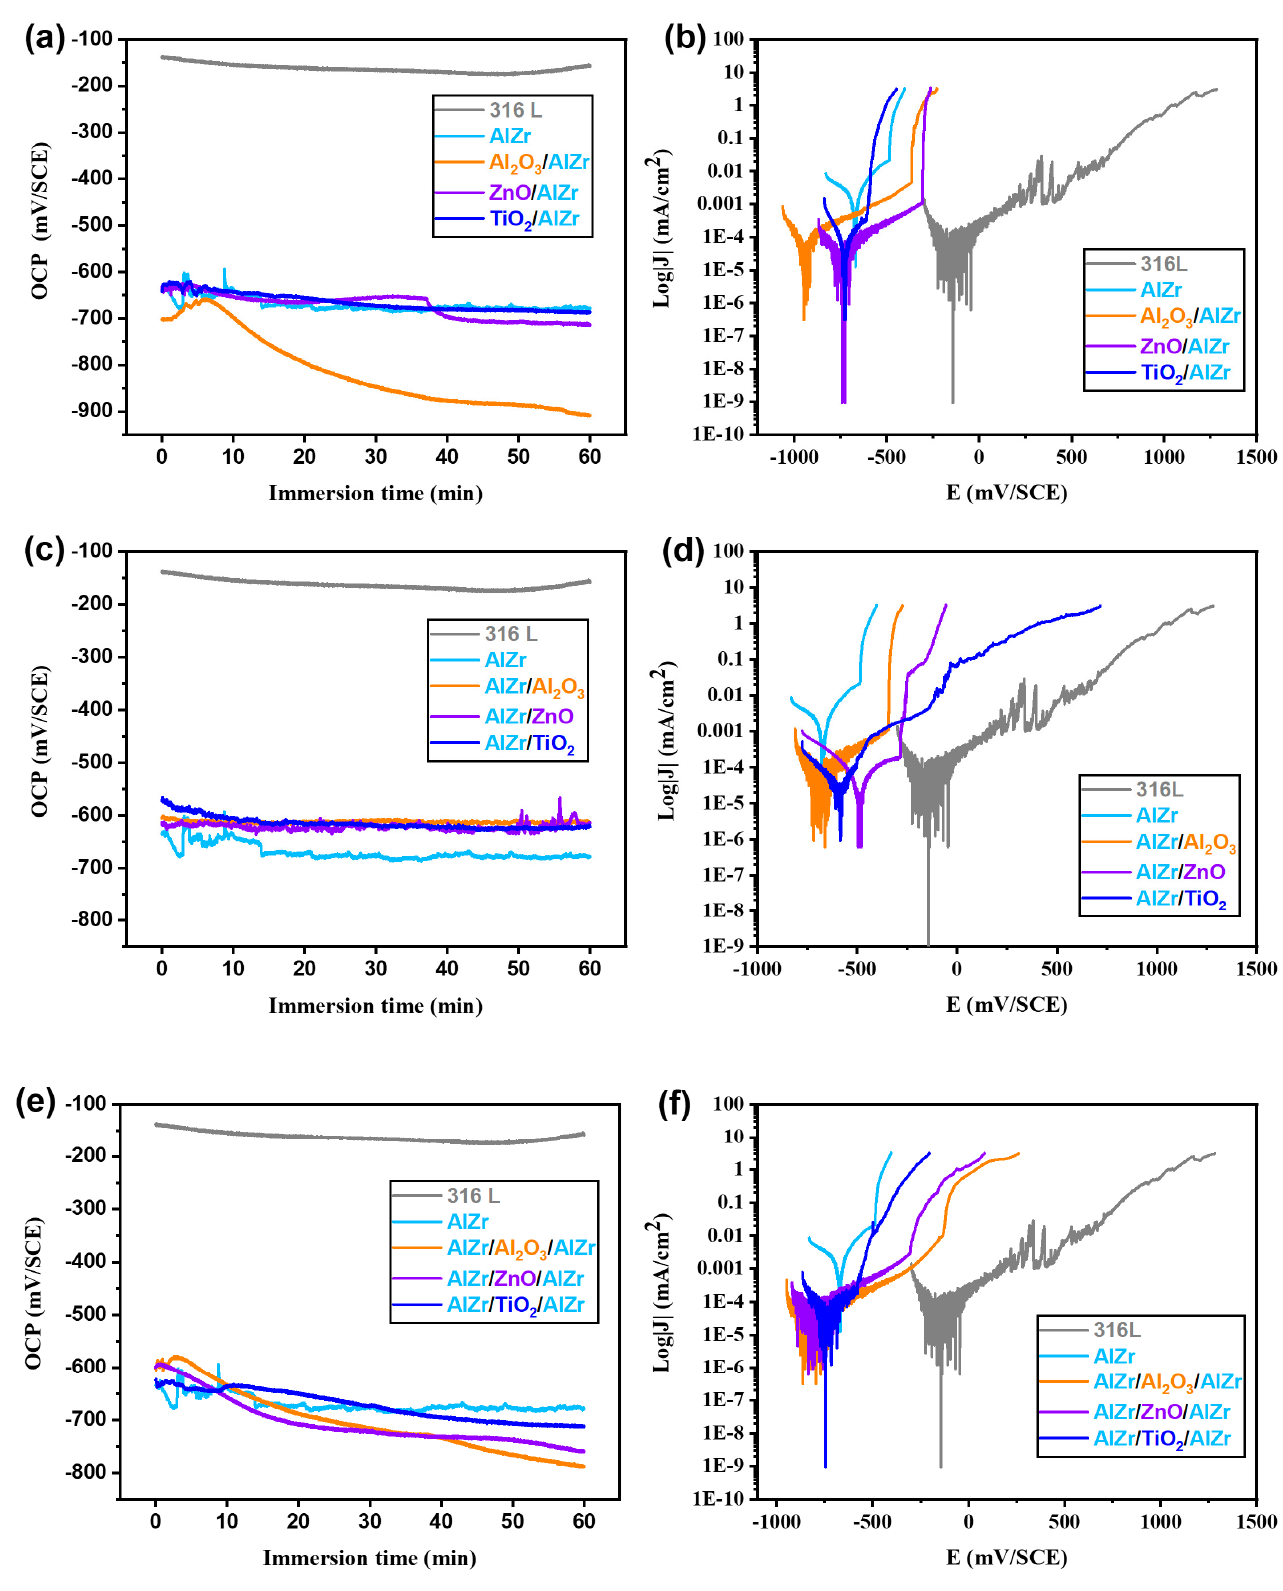
Figure 8. OCP and Tafel plots of the coatings tested in a saline solution (3.5 wt.% NaCl).